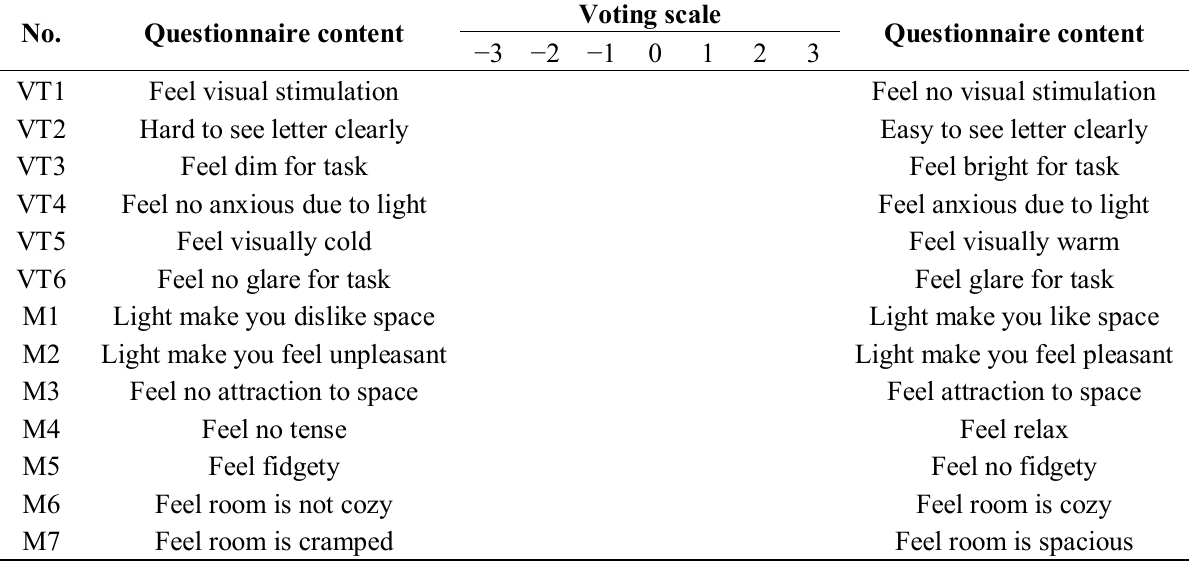
Table 3. Survey questionnaires for visual stimulation factors and